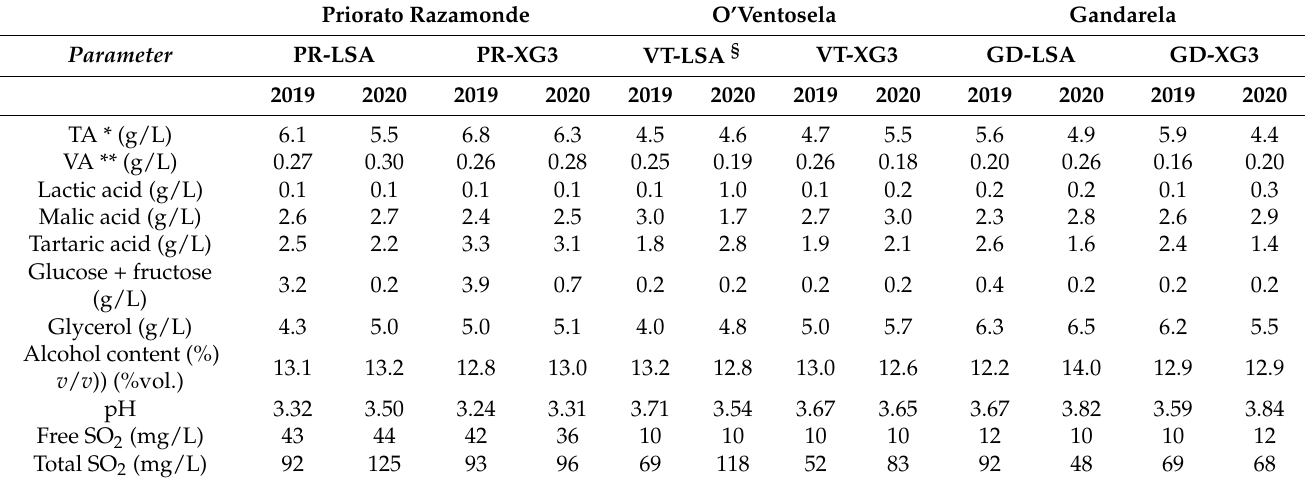
Table 3. Characteristics of Treixadura wines from Priorato de Razamonde (PR), O’Ventosela (VT) and Gandarela (GD) wineries obtained with different yeasts in 2019 and 2020 vintages.